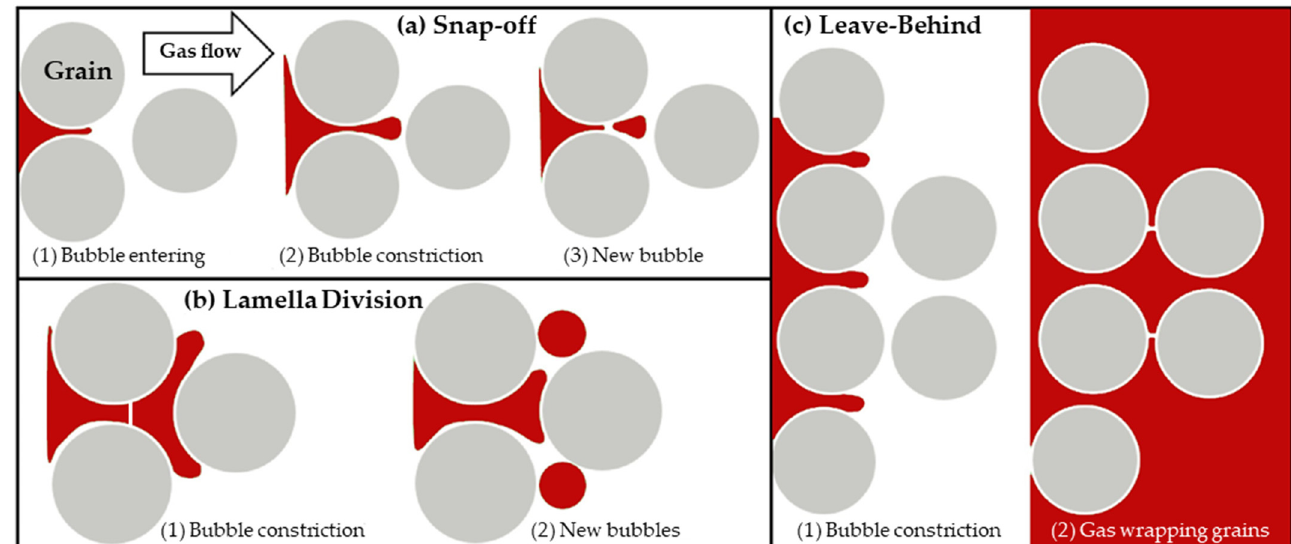
Figure 6. Three mechanisms of in situ bubble generation: ( a ) snap-off; ( b ) lamella division; and ( c ) leave-behind. The red region indicates the gas phase. Adapted with permission from Abdelgawad et al. [54]. 2022, Elsevier.